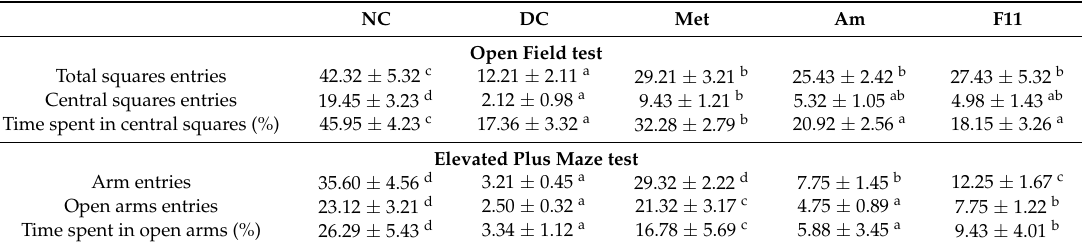
Table 5. Behavioral analysis using OFT and